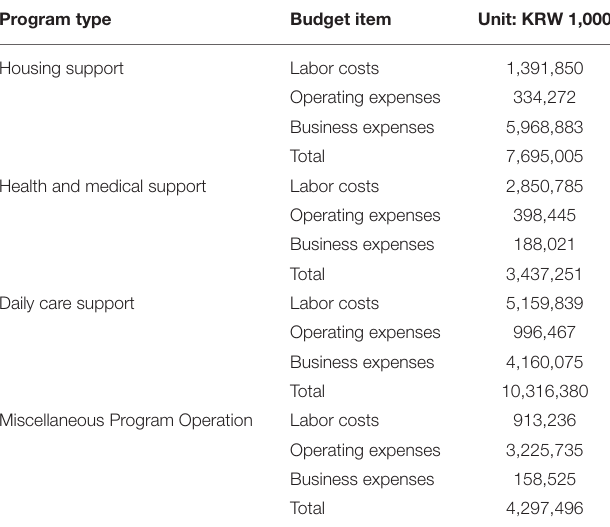
TABLE 5 | Composition of budget for integrated care for the elderly in local communities by